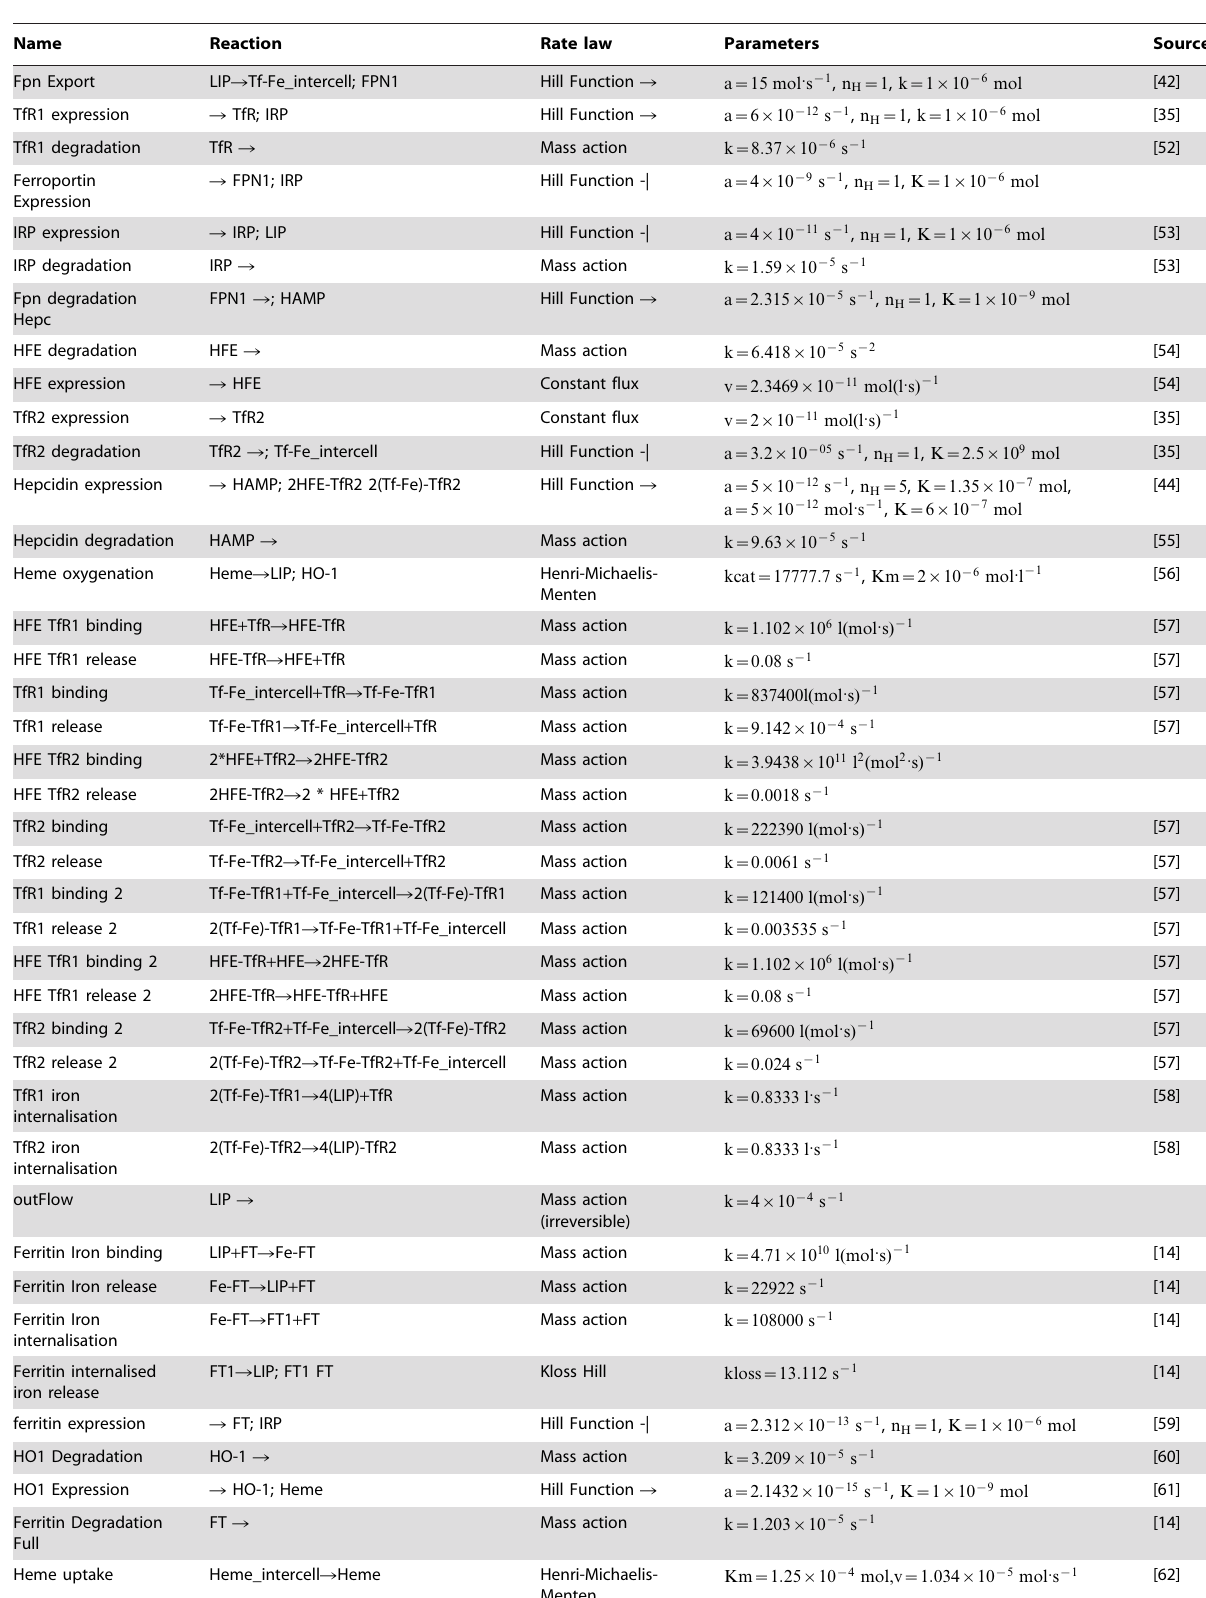
Table 1. Reactions, rate laws and kinetic constant values.